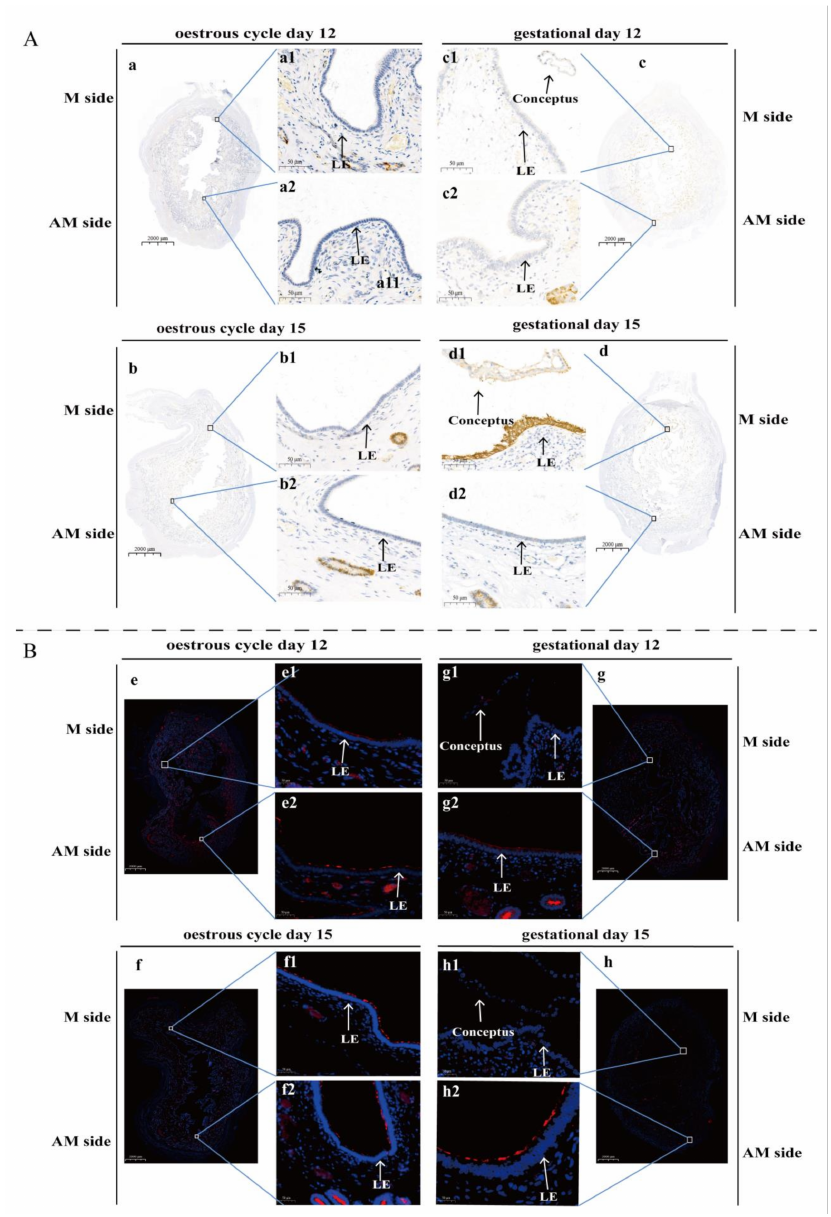
Figure 4. Spatial expression pattern of SULT2A1 and MEP1B in endometrial luminal epithelium within uterus of pigs. ( A ) Immunohistochemical analysis of SULT2A1 in the whole uterine cross- section of pigs ( n = 3 gilts/estrous cycle day or gestational day). ( B ) Immunofluorescence analysis of MEP1B in the whole uterine cross-section of pigs ( n = 3 gilts/estrous cycle day or gestational day). Representative images taken from the whole uterine cross-section at estrous cycle day 12 ( a , e ), estrous cycle day 15 ( b , f ), gestational day 12 ( c , g ) and gestational day 15 ( d , h ), respectively. Higher magnification images are shown of the localization of SULT2A1 in endometrial regions from the M side and AM side of the uterus respectively, and were taken from the same uterine cross-section at estrous cycle day 12 ( a1 , a2 ), estrous cycle day 15 ( b1 , b2 ), gestational day 12 ( c1 , c2 ) and gestational day 15 ( d1 , d2 ), respectively. Higher magnification images are shown of the localization of MEP1B in endometrial regions from the M side and AM side of the uterus respectively, and were taken from the same uterine cross-section at estrous cycle day 12 ( e1 , e2 ), estrous cycle day 15 ( f1 , f2 ), gestational day 12 ( g1 , g2 ) and gestational day 15 ( h1 , h2 ), respectively. LE: luminal epithelium; M side: mesometrial side; AM side: anti-mesometrial side. Scale bars = 50 µ